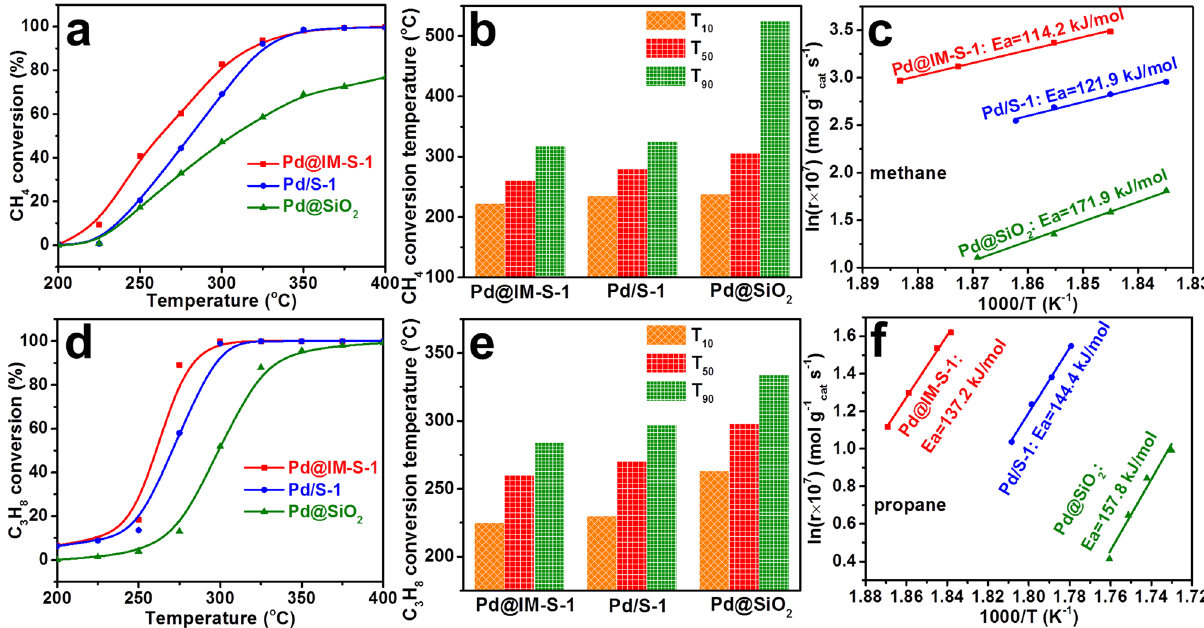
Fig. 5 Reaction performance of Pd@IM-S-1 and related catalysts. a , b Deep oxidation performances of methane, d , e deep oxidation performances of propane; c Arrhenius plots of methane oxidation, and f Arrhenius plots of propane oxidation with weight hourly space velocity (WHSV) of 180,000mL g cat. − 1 h − 1